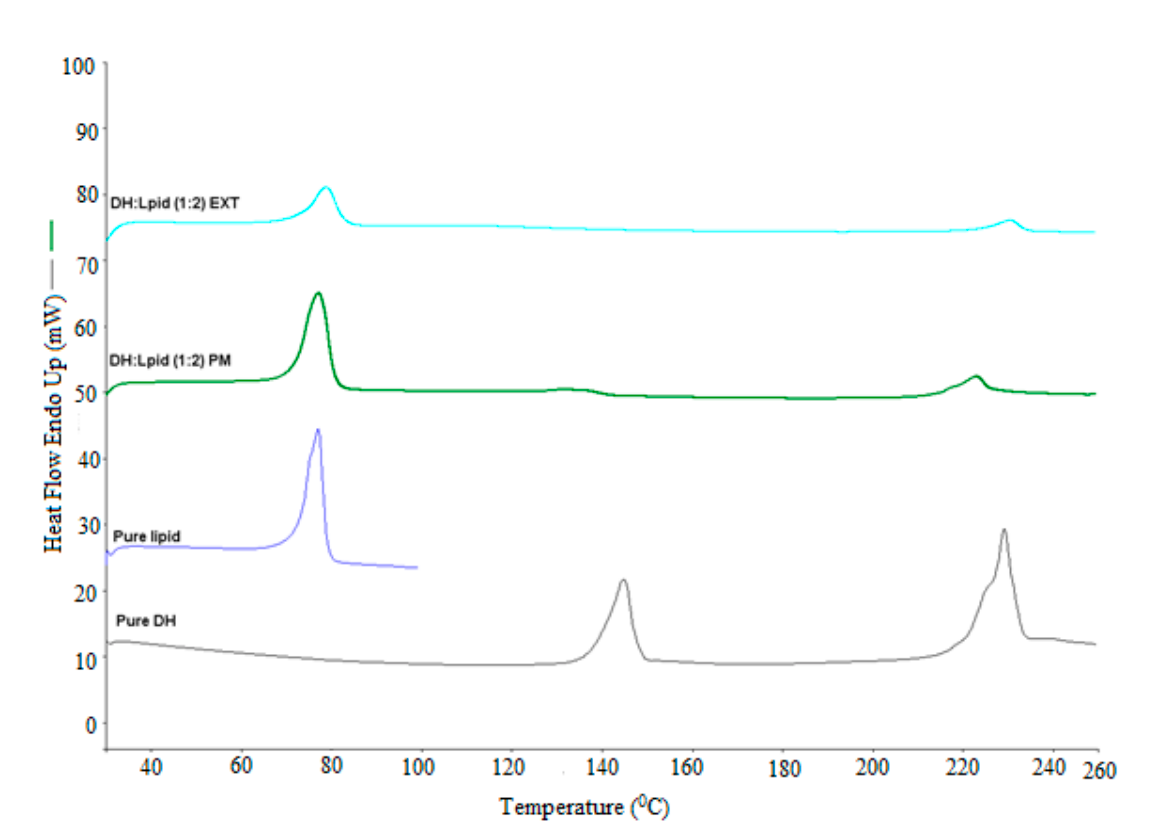
Figure 2. DH/C-888 and DH/C-888/MNT DSC studies performed at temperatures of 30–250 °C and a heating rate of 20 °C/min.